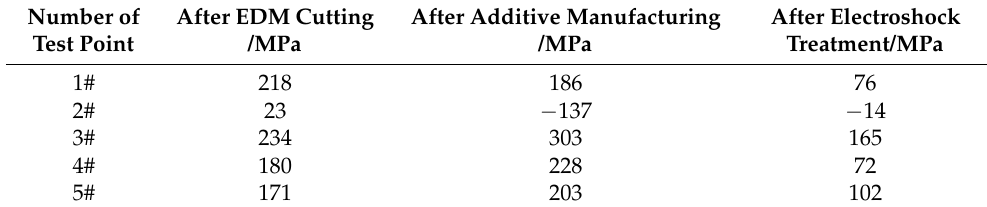
Figure 14. X-ray diffraction test points (mm). Table 4. The test results for residual stress in specimens.